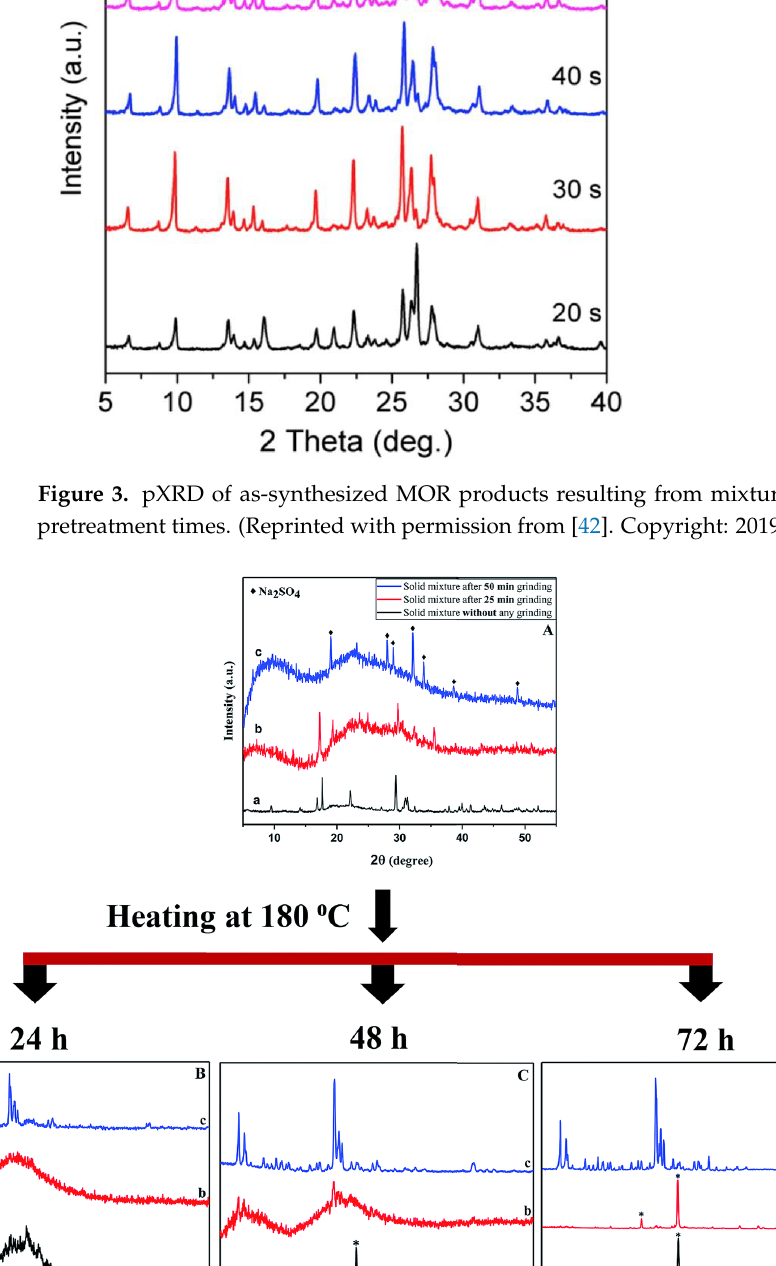
Figure 4. ( A ) XRD of solid precursor mixture reagent mixture of Na 2 SiO 3 , Al 2 (SO 4 ) 3 , and SiO 2 (equivalent Na 2 O:Al 2 O 3 :SiO 2 ratio of 5:1:30) ground for different periods of time (a—no grinding, b—25 min, and c—50 min). Asterisks in A indicate Na 2 SO 4 . The XRD of washed products after heating at 180 °C for periods of: 24 h ( B ), 48 h ( C ), and 72 h ( D ). Asterisks in ( C ) and ( D ) indicate quartz peaks. (Reprinted from [44]. Published by The Royal Society of Chemistry).